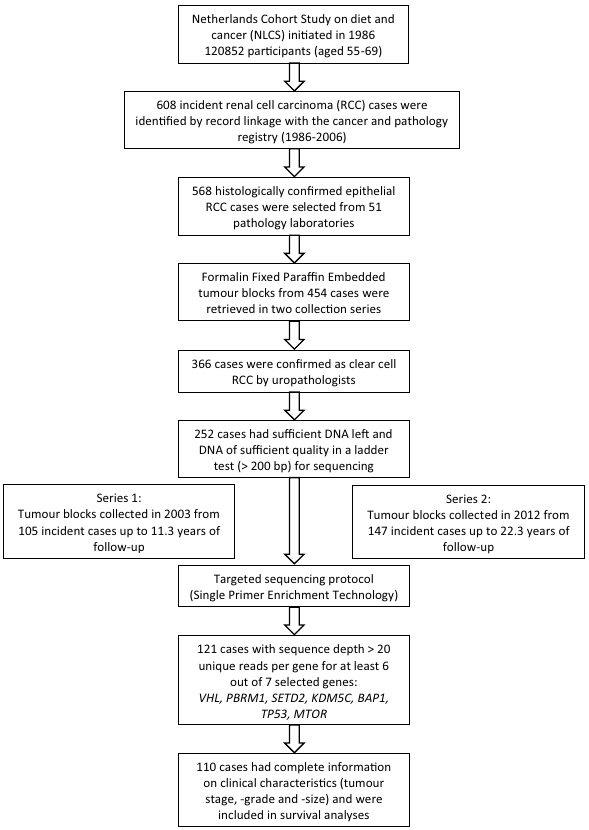
Figure 3. Overview of sample selection of clear cell renal cell carcinoma cases from the Netherlands cohort study on diet and cancer (NCLS), in which DNA collection was performed in two series: Series 1 (collected in 2003) and Series 2 (collected in